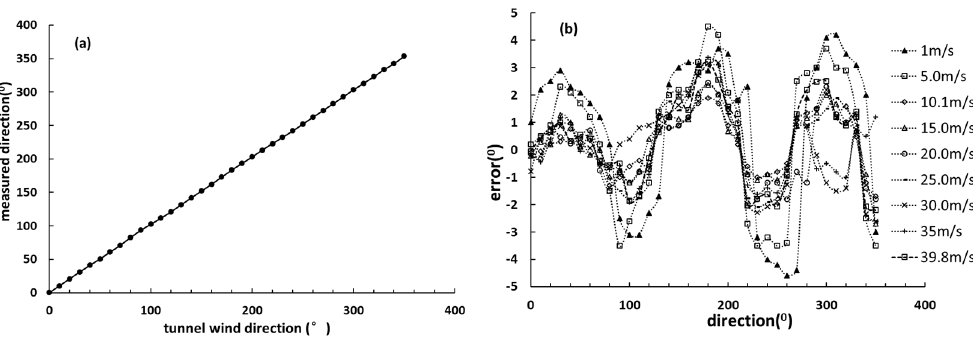
Figure 10. The wind direction test results, ( a ) The linear wind direction relationship and ( b ) the relative errors.